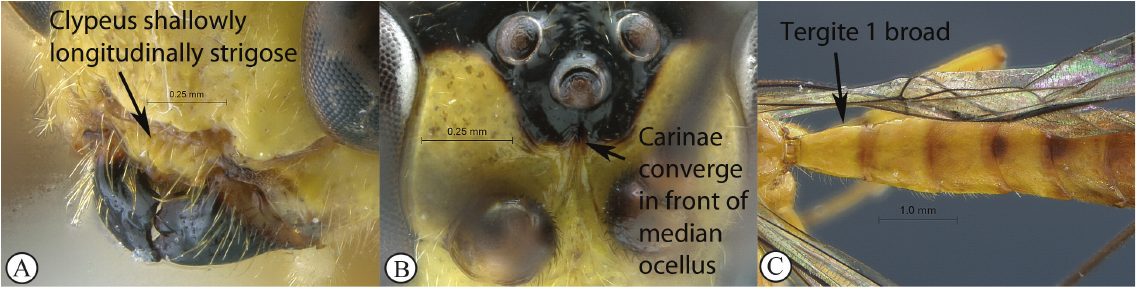
11. Clypeus shallowly longitudinally strigose (A); frons with two medial carinae converging in front of median ocellus (B); tergite 1 of female stout, less than 1.4x longer than apically wide (C)